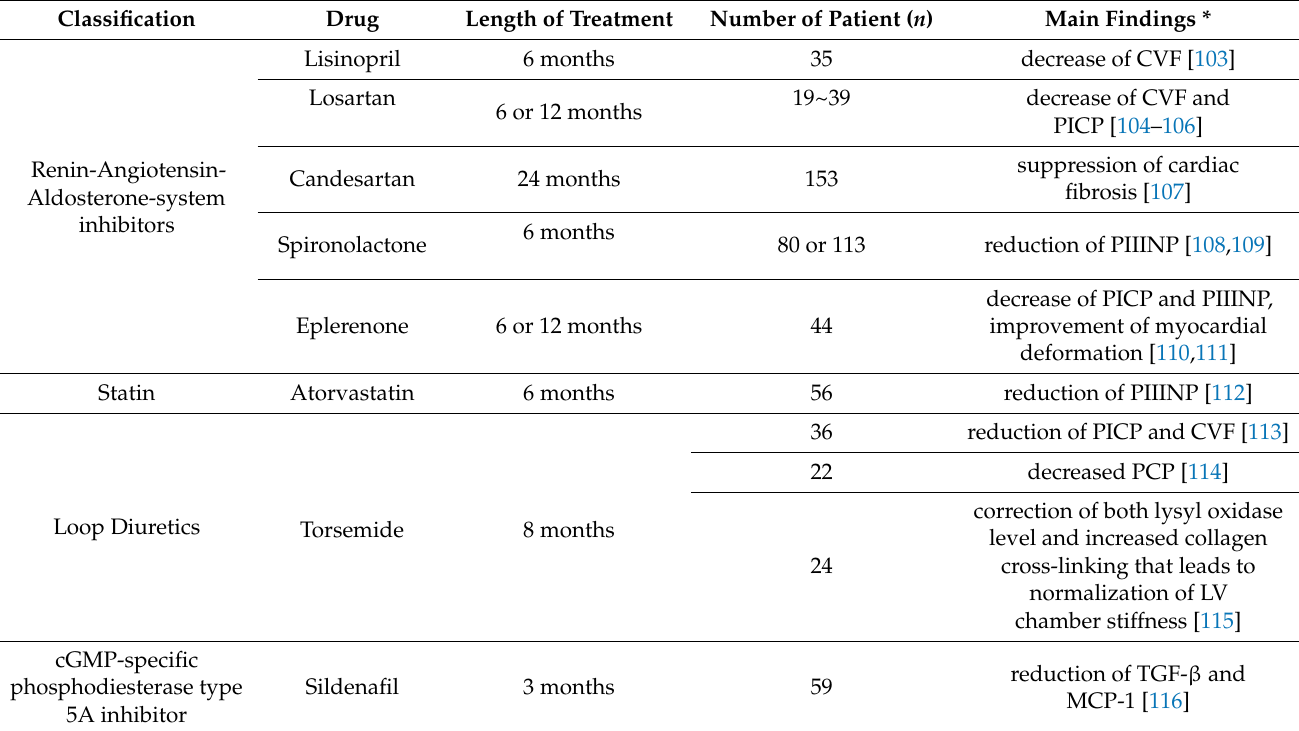
Table 2 is modified from [117]. * Abbreviation of main findings are as follows: CVF, collagen volume fraction; PICP, the carboxy-terminal peptide of procollagen type I; PIIINP, the amino-terminal peptide of type III procollagen; PCP, procollagen type I carboxy-terminal proteinase; LV, left ventricular; MCP-1, monocyte chemoattractant